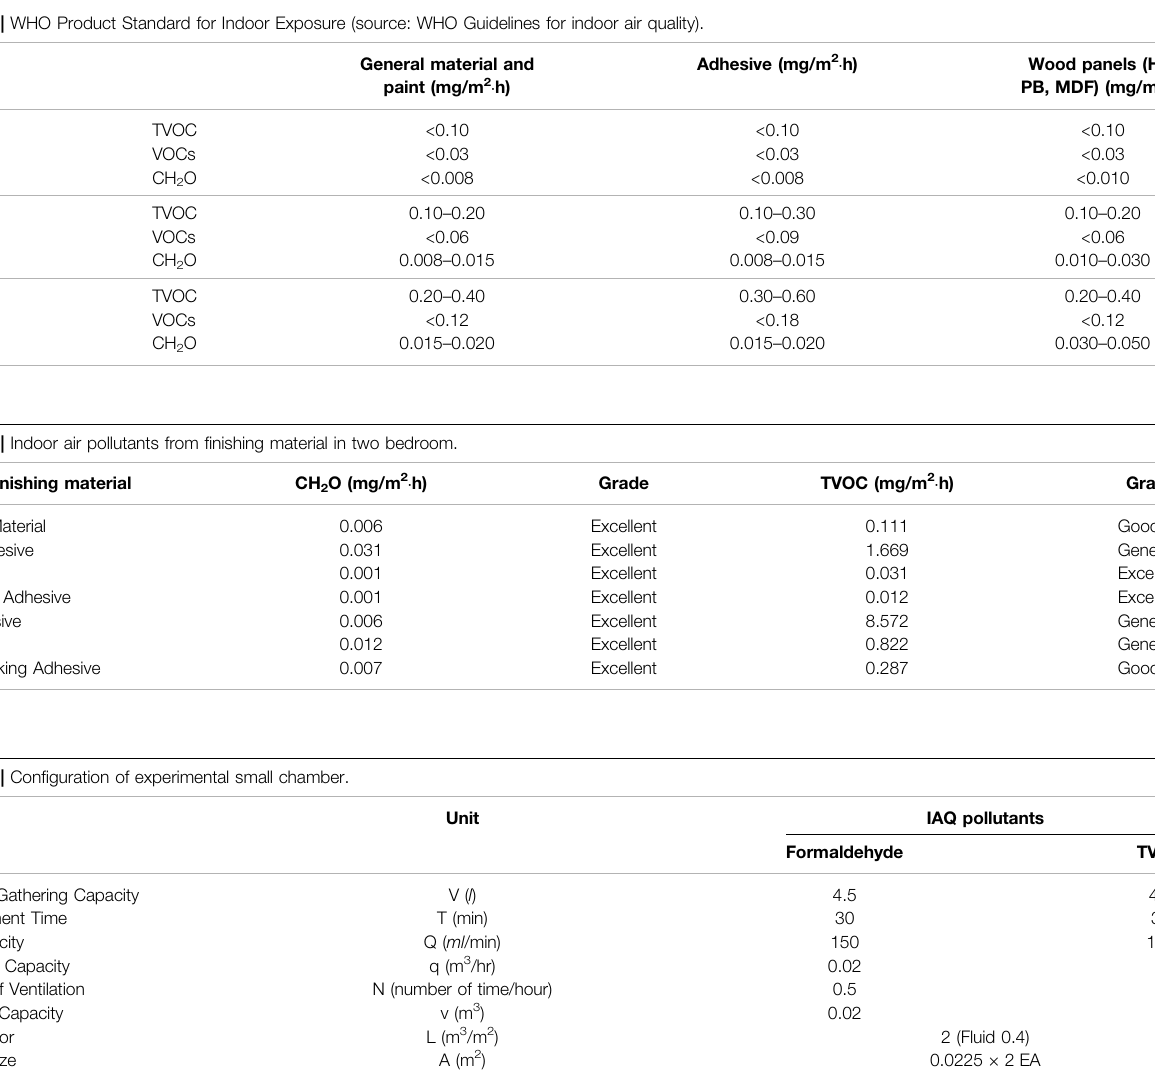
TABLE 6 | WHO Product Standard for Indoor Exposure (source: WHO Guidelines for indoor air quality). Category